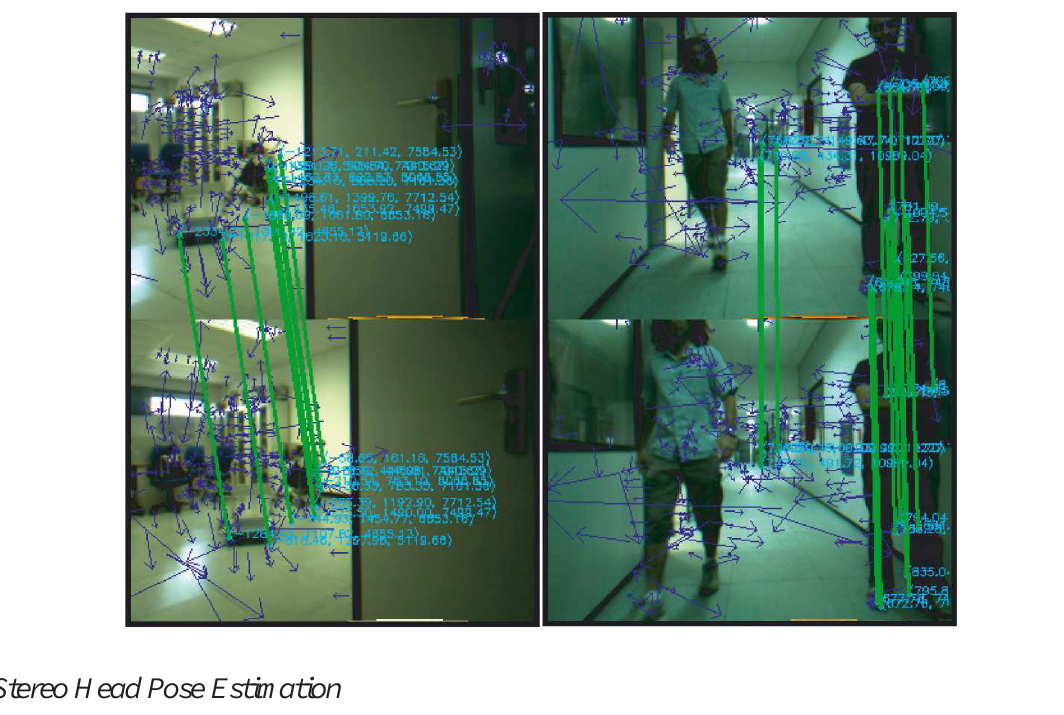
Figure 6. Feature association results for two different displacements. After applying the maximum-weighted clique algorithm the number of pairwise matched features is 7 and 13 for the left and right images, respectively (3D coordinates of the landmarks are also